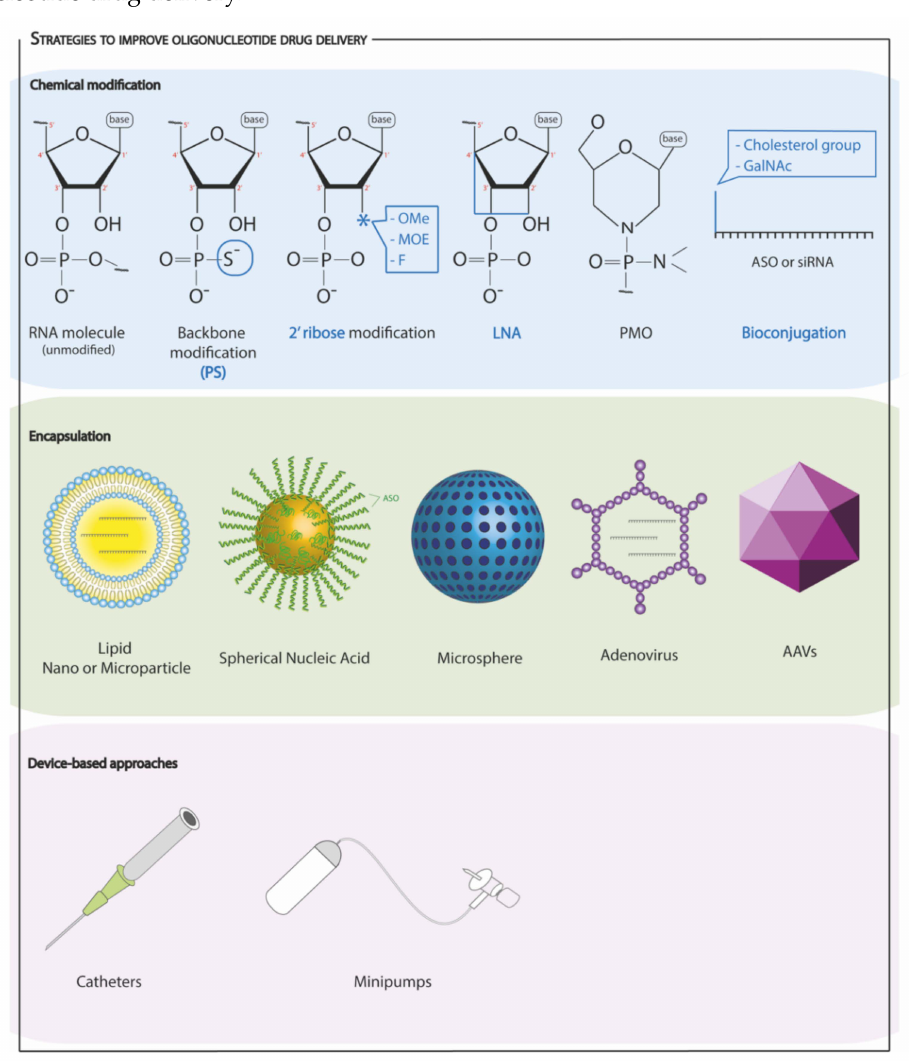
Figure 2. Different strategies to improve the delivery of oligonucleotide-based